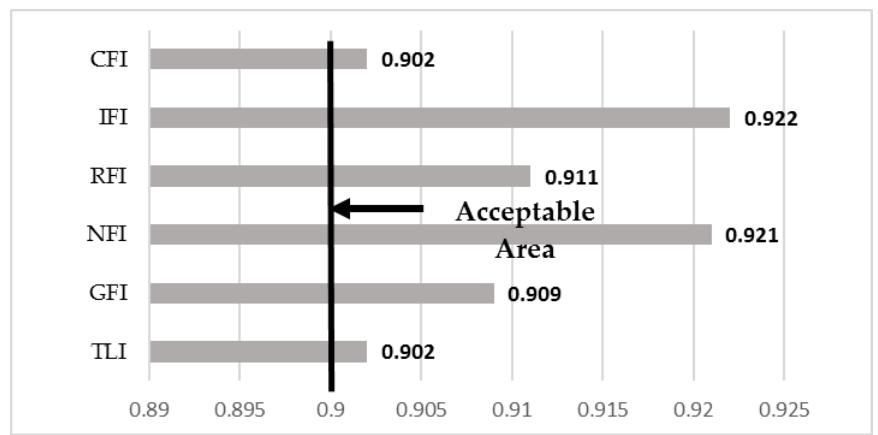
Figure 2. SEM model fitting.